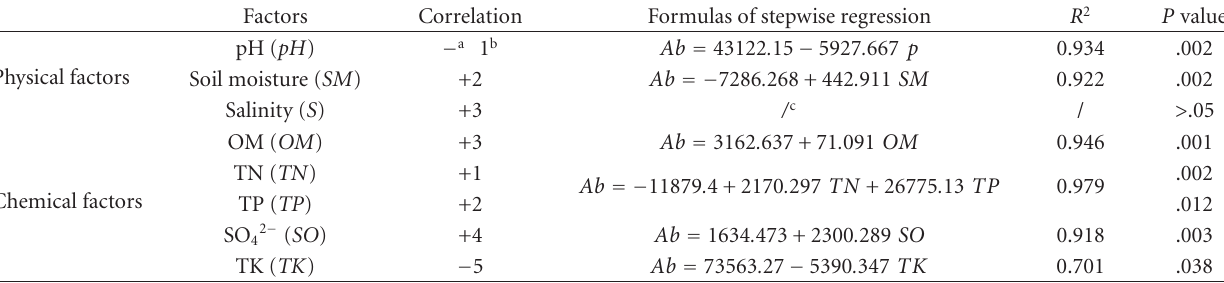
Table 5: Correlation of ciliate abundance (ind. g − 1 )) with soil physical/chemical properties in fresh samples.